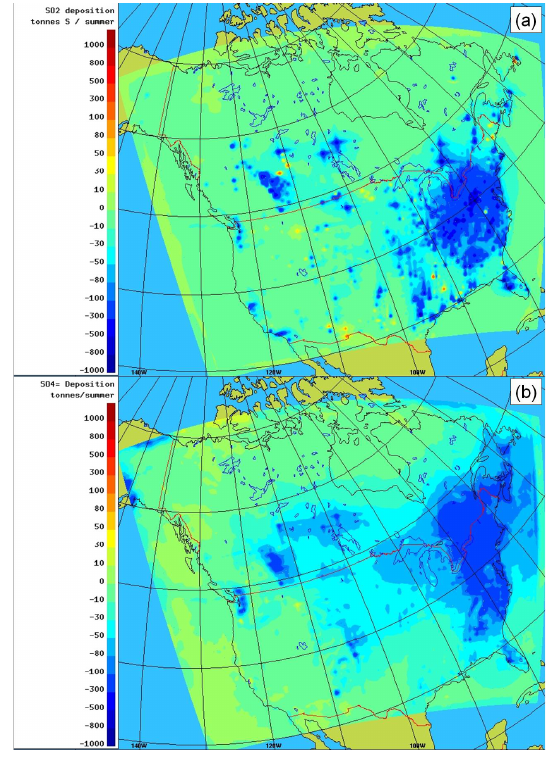
Fig. 16. Two main contributors to changes in S deposition 1 CE, Tonnes/summer. (a) Dry Deposition of gaseous SO 2 , (b) Wet de- position of SO 2 − (aq). Note that positive and negative scales have a 4 logarithmic